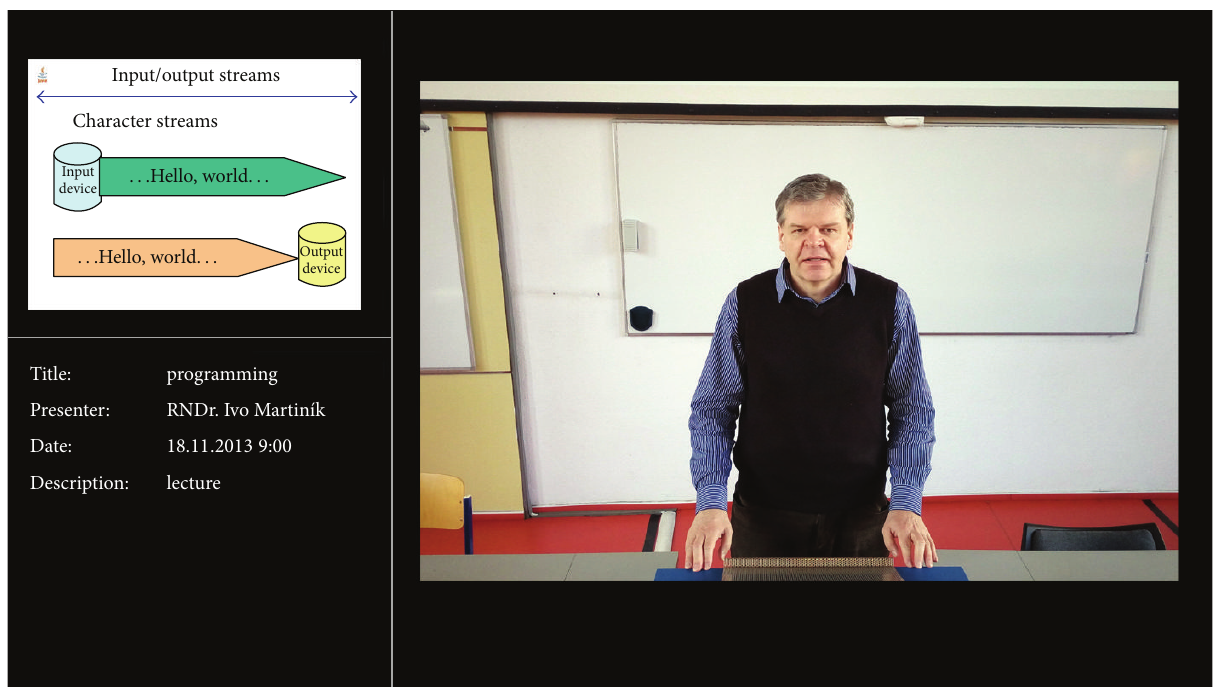
Figure 12: Shot of detail-view type in audiovisual lecture